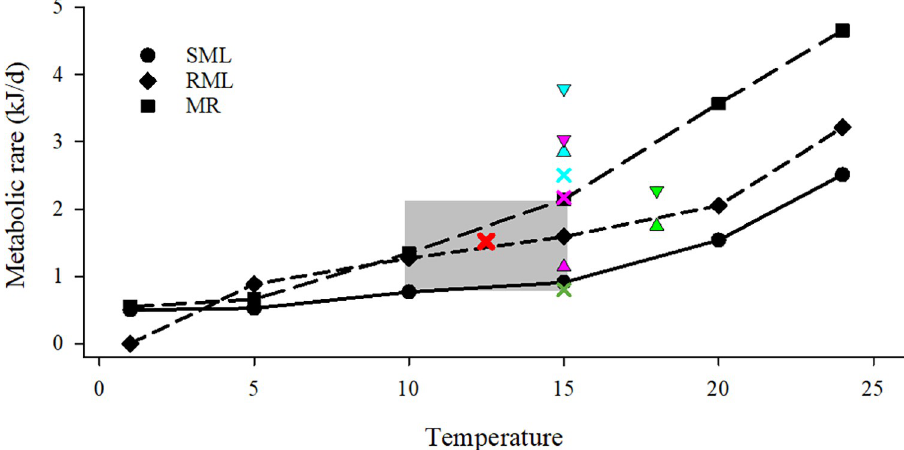
Fig 2. Calculated metabolic rates in relation to temperature for a 155 mm (0.038 kg) juvenile salmon. This equates to an energy requirement of 40 kJ/kg/d (40 = 1.52 / 0.038). Lines: Standard metabolic level (SML), routine metabolic level (RML), and maintenance ration (MR) for Sockeye Salmon (black lines and symbols [50]). Shaded area denotes rates within the 10–15˚C range. Symbols: SML for rainbow trout: blue triangle [51]; green triangle [53]; green cross [54]; blue cross [55]. SML for Atlantic Salmon: pink cross [56]. MR for rainbow trout: blue triangle [51]. Up and down triangles represent range of values. Red X, metabolic rate used in estimation.